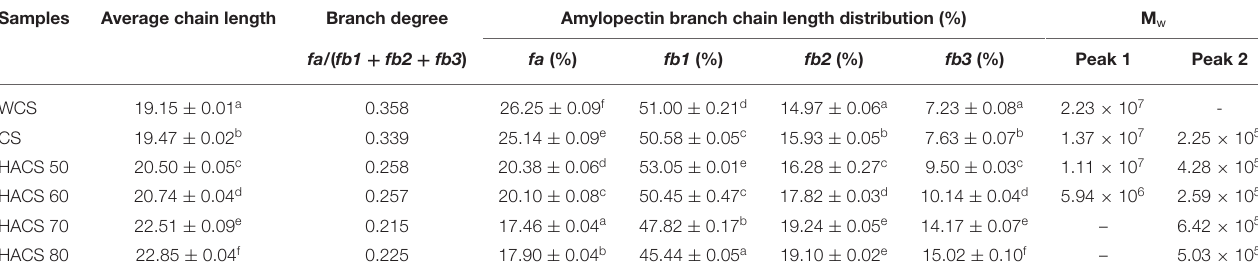
TABLE 4 | Debranched chain length distributions and weight-average molecular weight of corn starch with different amylose content. Samples